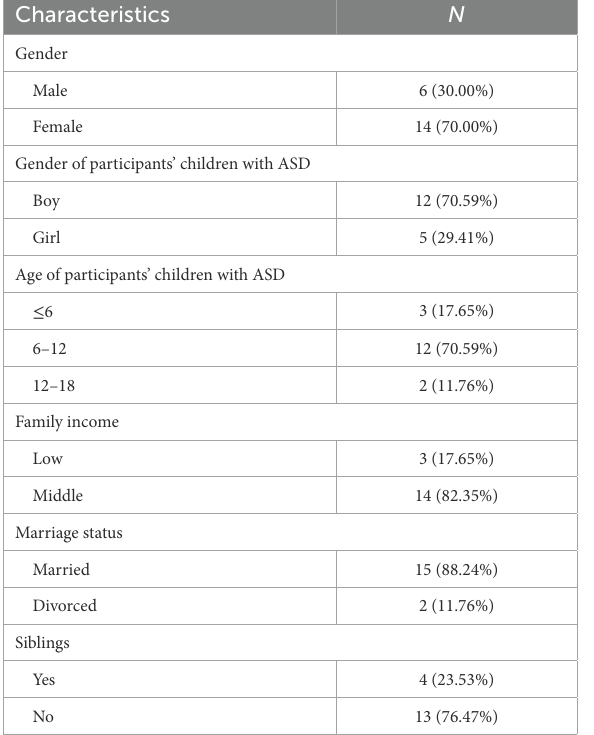
TABLE 2 Demographic data of participants.